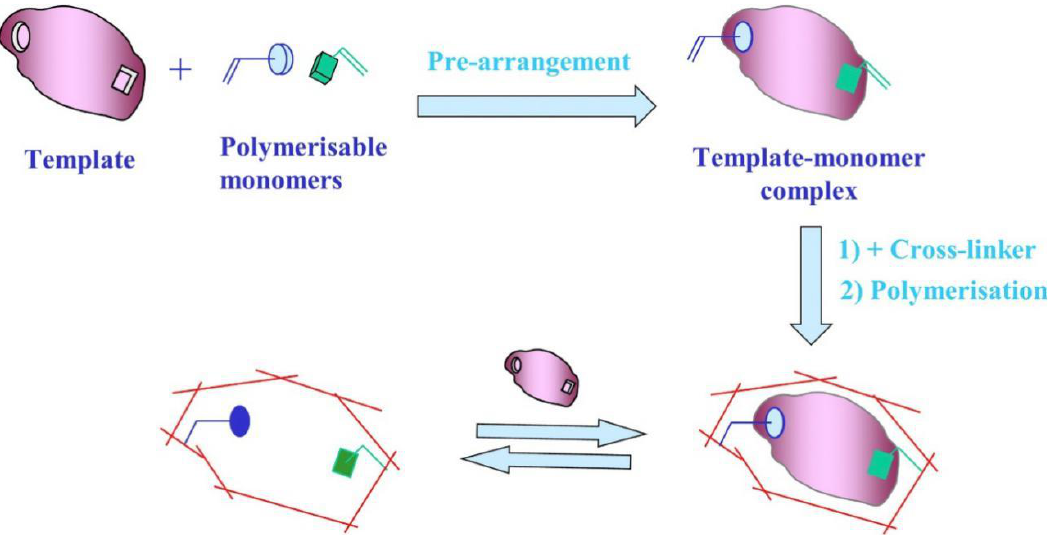
Figure 1. Preparation of MIPs. Adapted with permission from Ref. [24] . Copyright 2019, Elsevier.